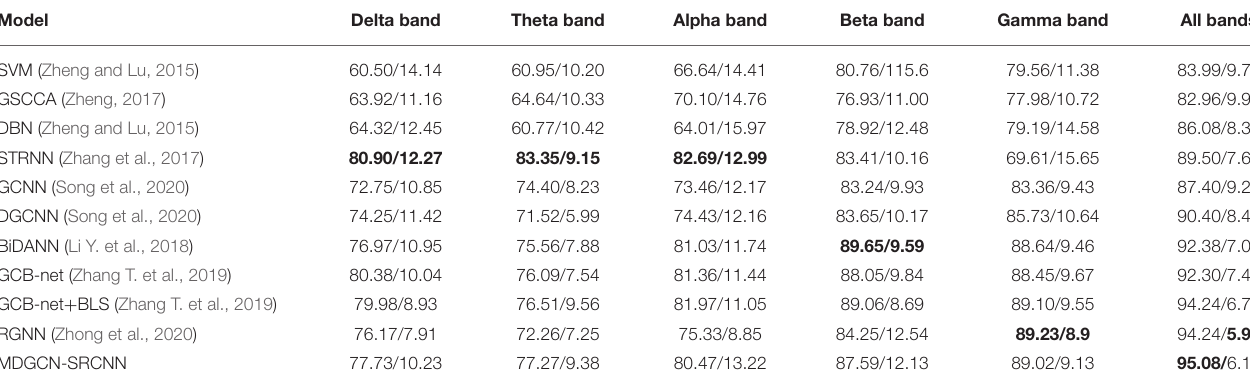
TABLE 2 | Compare the accuracy rate (mean/std) with different existing methods on the SEED data set.